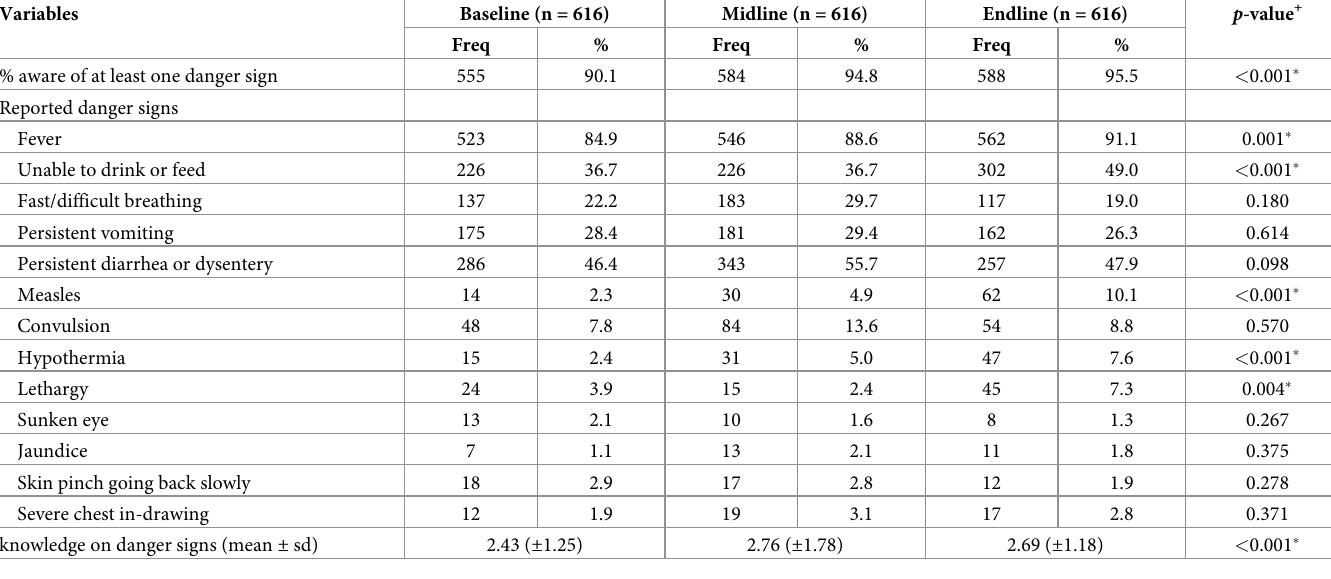
Table 3 summarizes the care-seeking for common childhood illness from different health facil- ities during the three survey rounds. Over the period, care-seeking from any formal provider and from health posts significantly increased by 10.7 and 17.4 percentage points (PP) from baseline levels of 64.5 and 34.1%, respectively ( p < 0.001). However, care-seeking from health centres ( p = 0.420) and public hospitals ( p = 0.129) remained unchanged while care-seeking from private providers significantly declined ( p = 0.003). Results for individual medical conditions demonstrated a similar pattern. During iCCM implementation, care-seeking from health posts for treatment of diarrhea (19.2 PP, p < 0.001), fever (15.5 PP, p < 0.001), cough (17.8 PP, p < 0.001) and cough with breathing difficulty (17.3 PP, p = 0.038) significantly improved (Table 4). Table 3. Caregivers’ knowledge of childhood illness danger signs, Assosa zone, Ethiopia, 2017–2018.